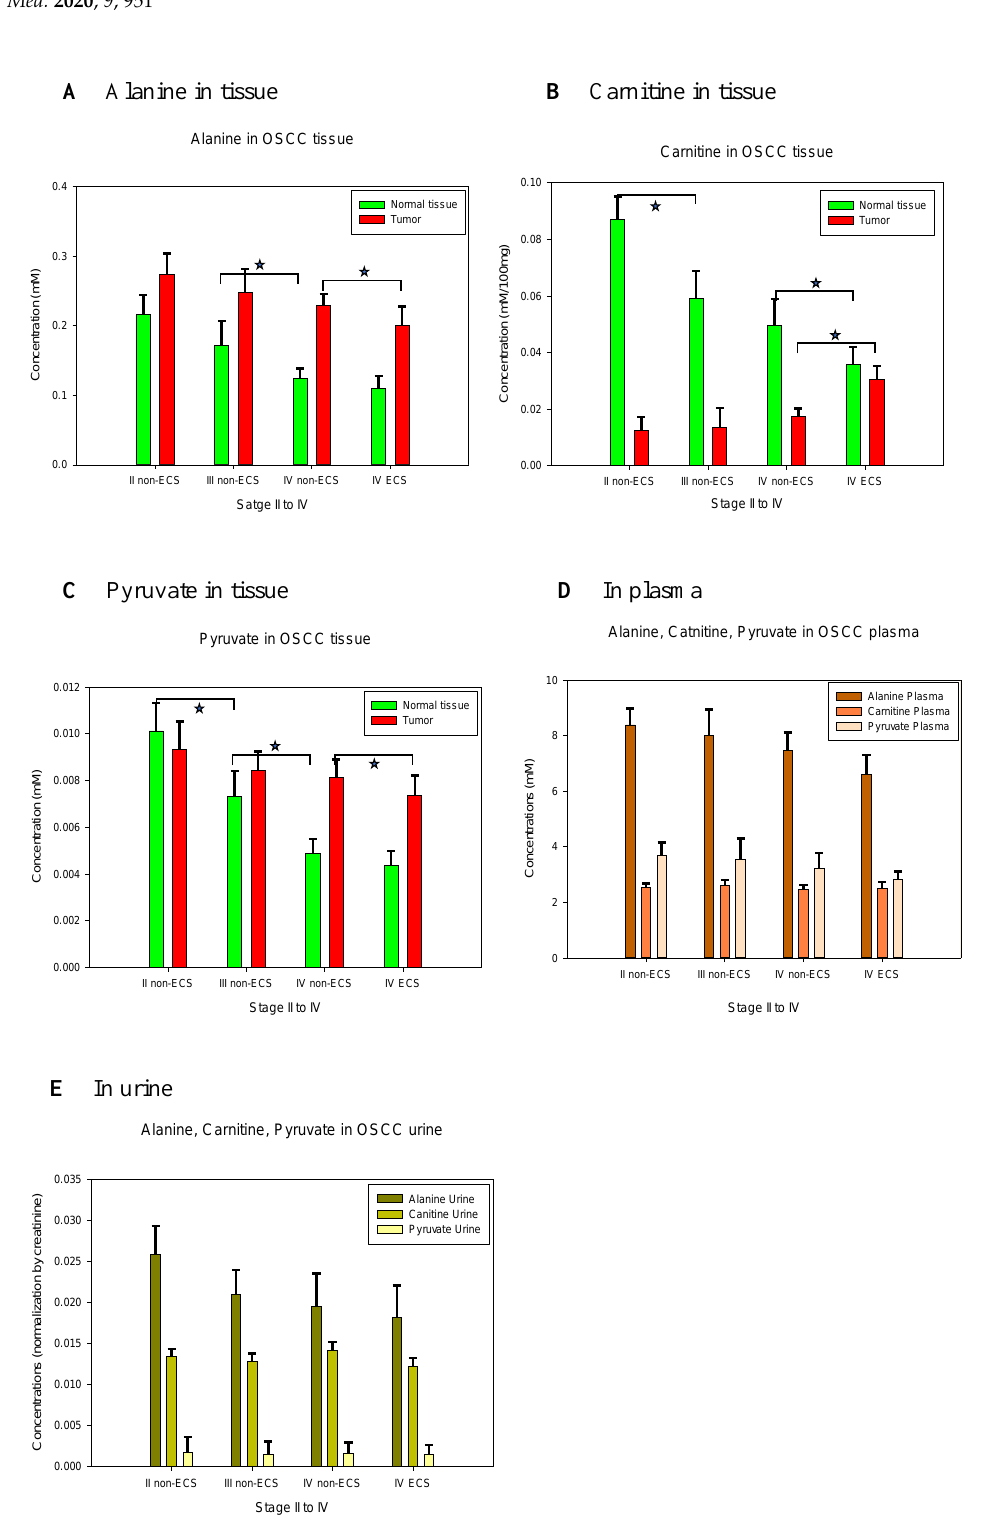
Figure 2. Metabolite-concentrations of alanine, carnitine, and pyruvate in tumor, adjacent normal tissue, plasma and urine from stage II to IV oral squamous cell carcinoma (OSCC) accompany with its extranodal extension (ENE) status: in tissue for alanine ( A ), carnitine ( B ), and pyruvate ( C ); in plasma ( D ) and in urine ( E ). Carnitine level significantly increased in the tumors stage and significantly decreased in adjacent normal tissue. Decreased levels of alanine and pyruvate were observed in the tumor stage and in adjacent normal tissue. Decreased level of alanine was observed in plasma and urine samples. * p <